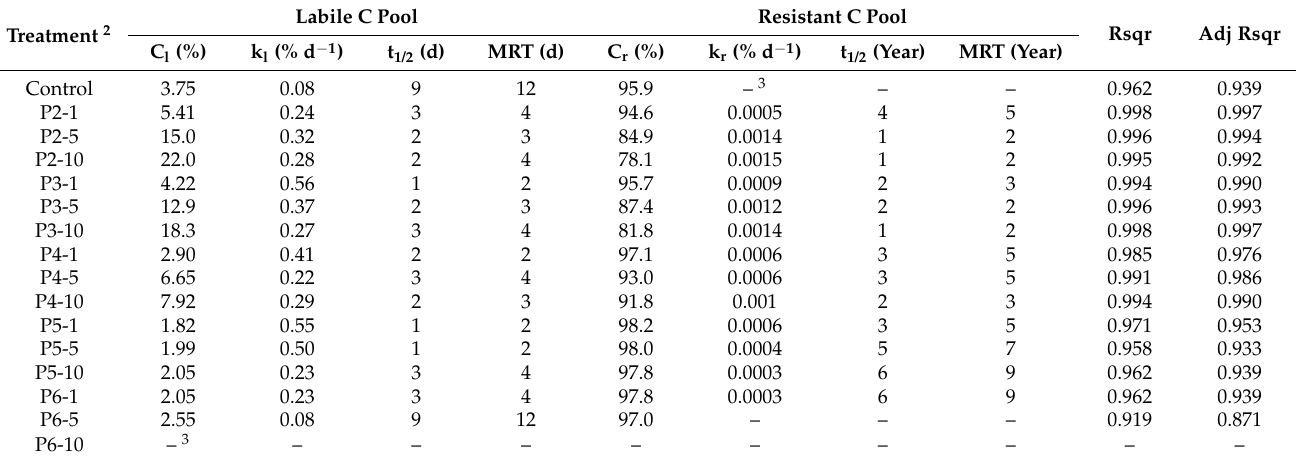
Table 2. Kinetic parameters 1 of carbon